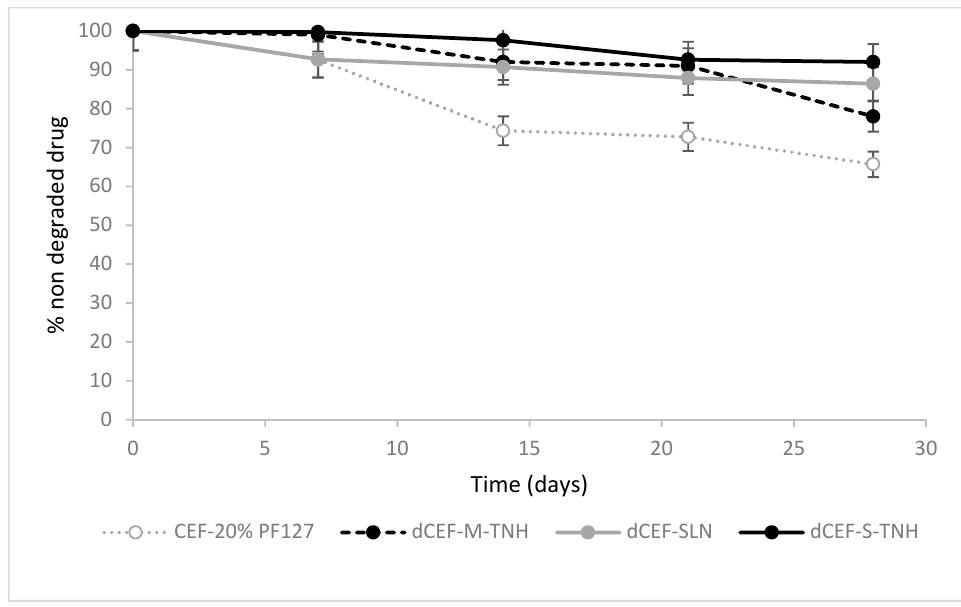
Figure 6. Physico-chemical stability at 4 °C of blank SLN (white) and of dCEF-SLN (grey) and dCEF- S-TNH (black) in term of: ( a ) mean size and ( b ) ζ potential. Each bar represents the mean ± SD ( n = 5); * ( p < 0.05).